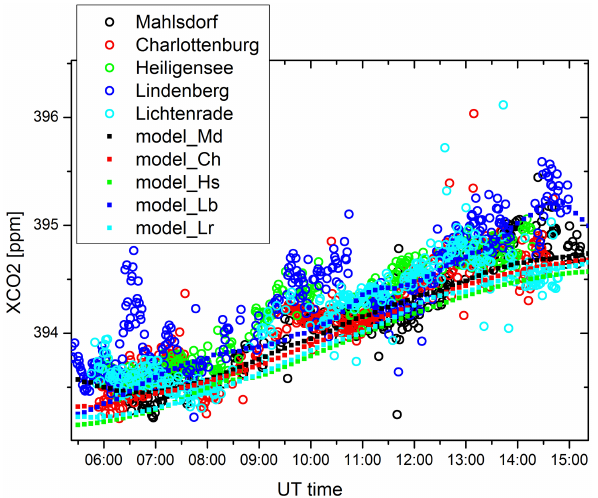
Figure 7. Observed and modelled XCO 2 for 3 July. The model en- hancements are shown superimposed on a smooth polynomial back- ground which has been derived from the observations of the up- stream stations.